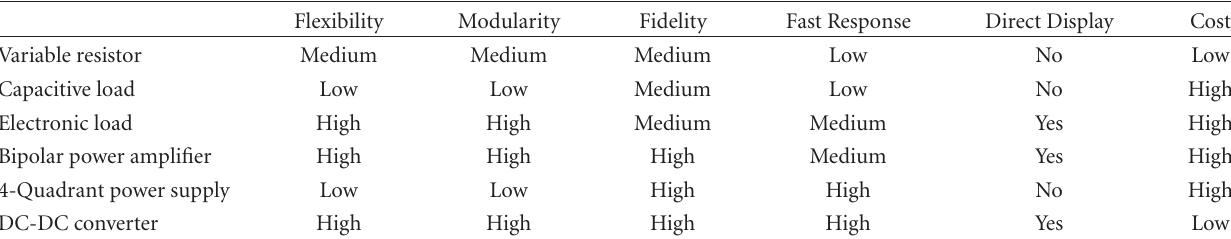
Table 5: Comparison between di ff erent